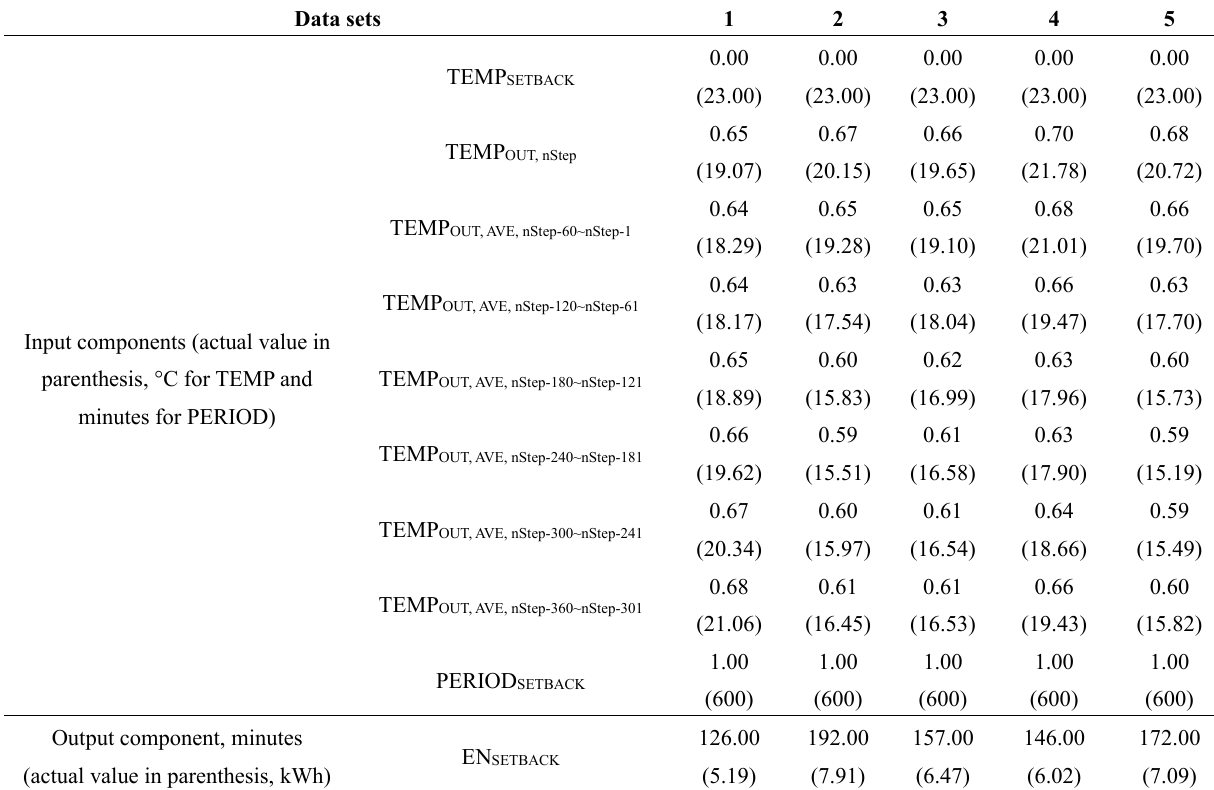
Table 4. Composition of the training data